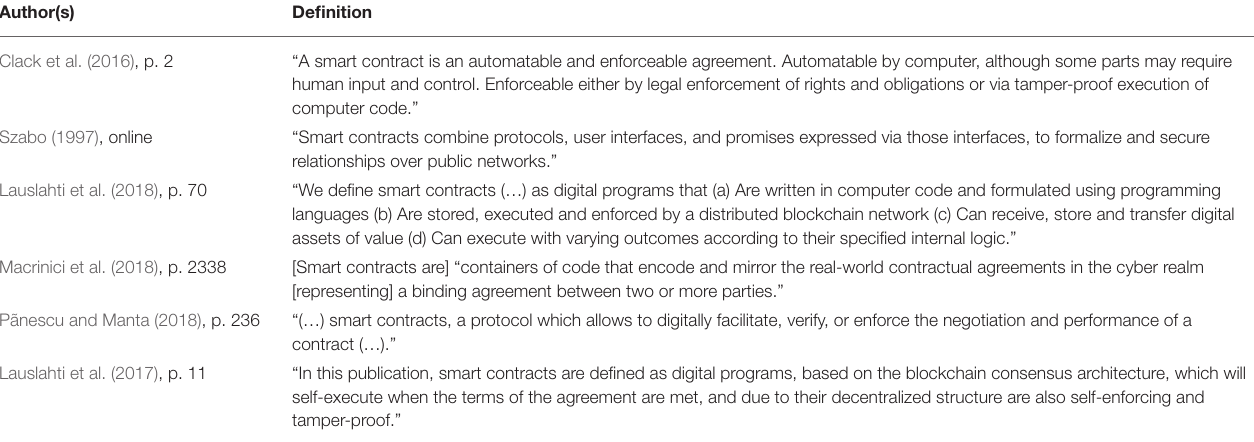
TABLE 1 | Smart contract definitions (based on respective